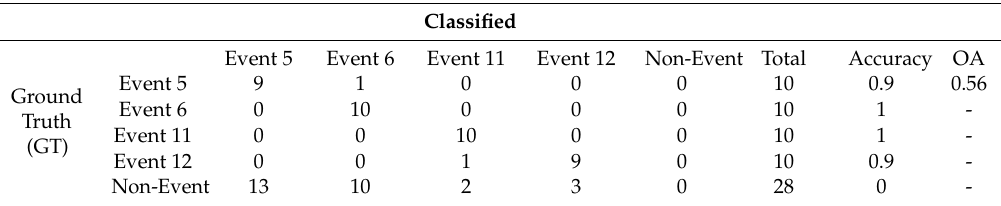
Table 2. Event Classification performance using VideoGraph only for 20 VIRAT videos. In addition to a confusion matrix, the overall accuracy (OA) was also included.